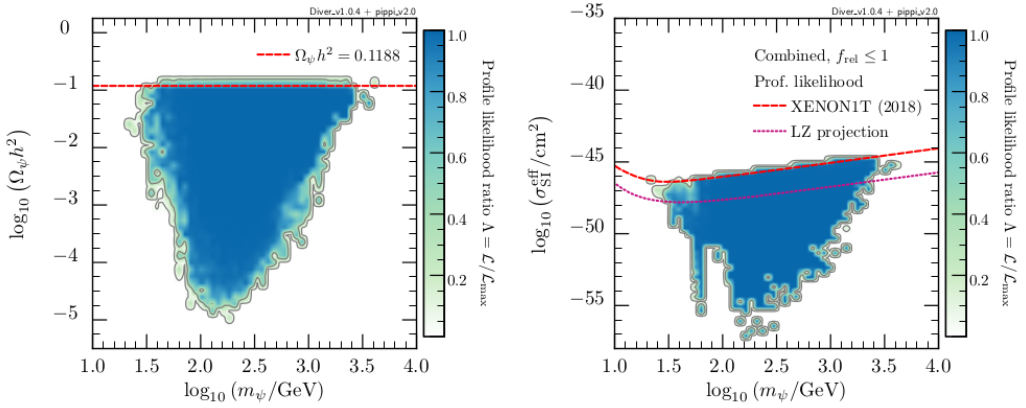
Figure 5 . 1D PL plots for m H (left), m (center) and g S (right) assuming f rel (cid:20) 1. The respective plots for s 0 , (cid:22) 3 and (cid:21) S are not shown as they are unconstrained by our global (cid:12)t.